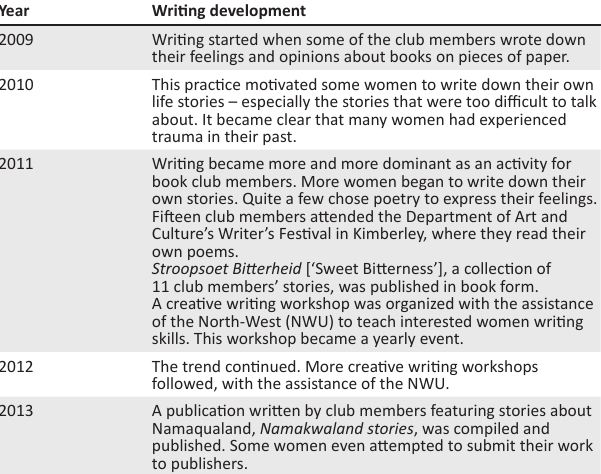
TABLE 8: Themes identified from monthly and yearly reports and field notes: Writing development.